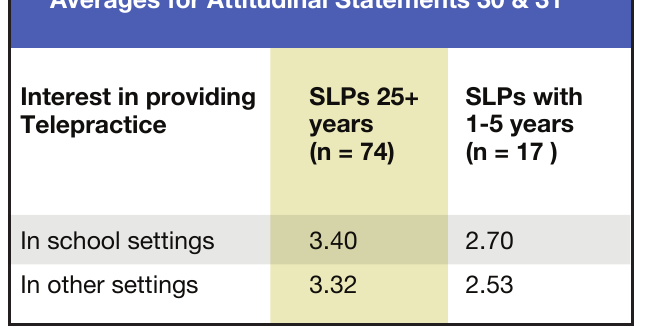
Note. Scale of 1 Strongly agree to 5 Strongly